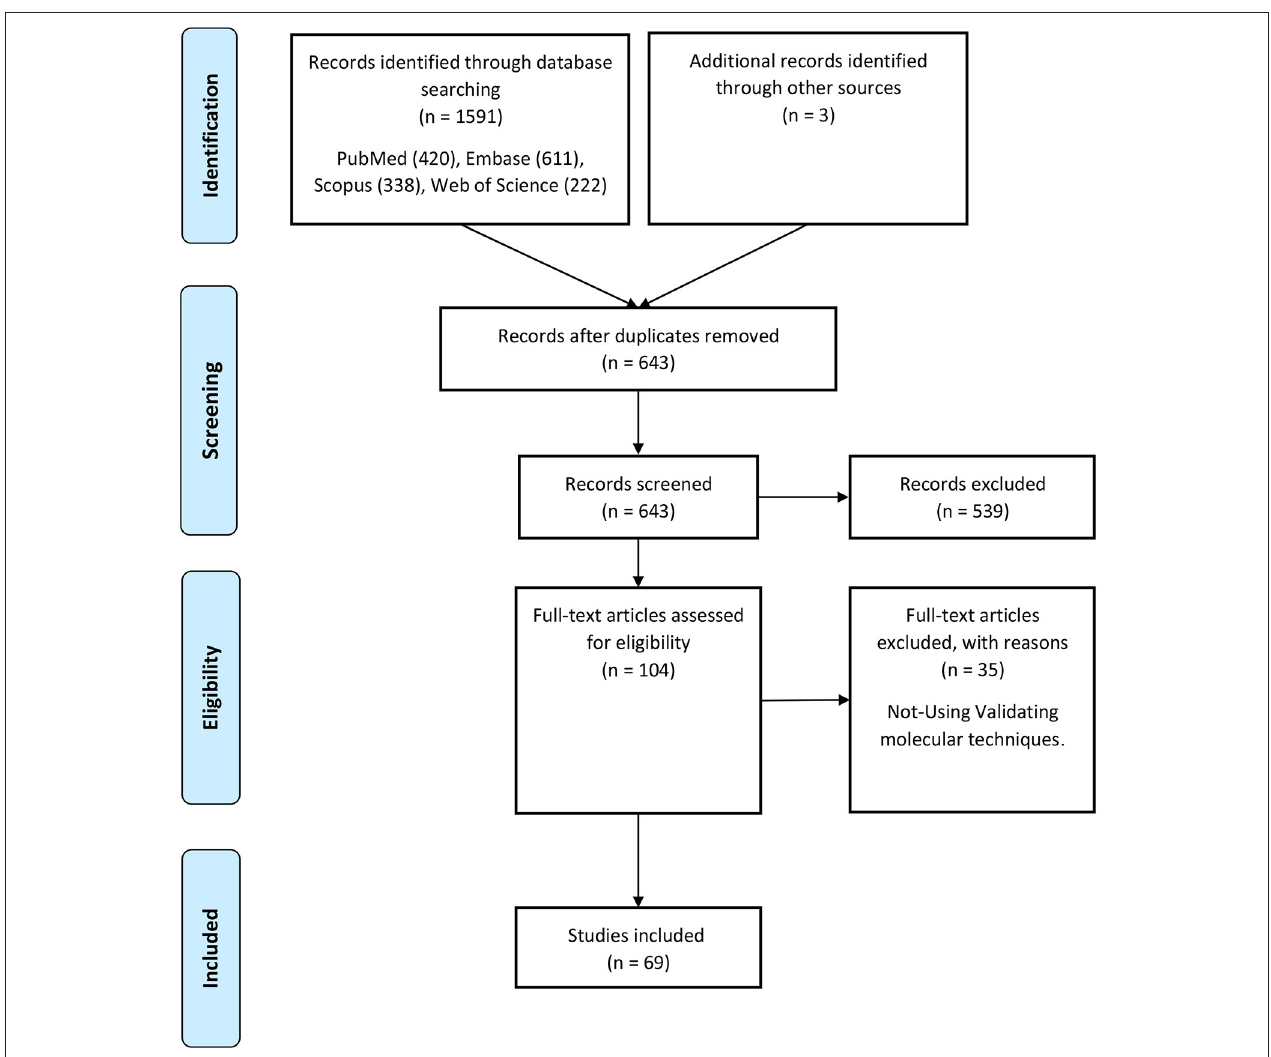
FIGURE 1 | Flow chart of search strategy based on PRISMA flow